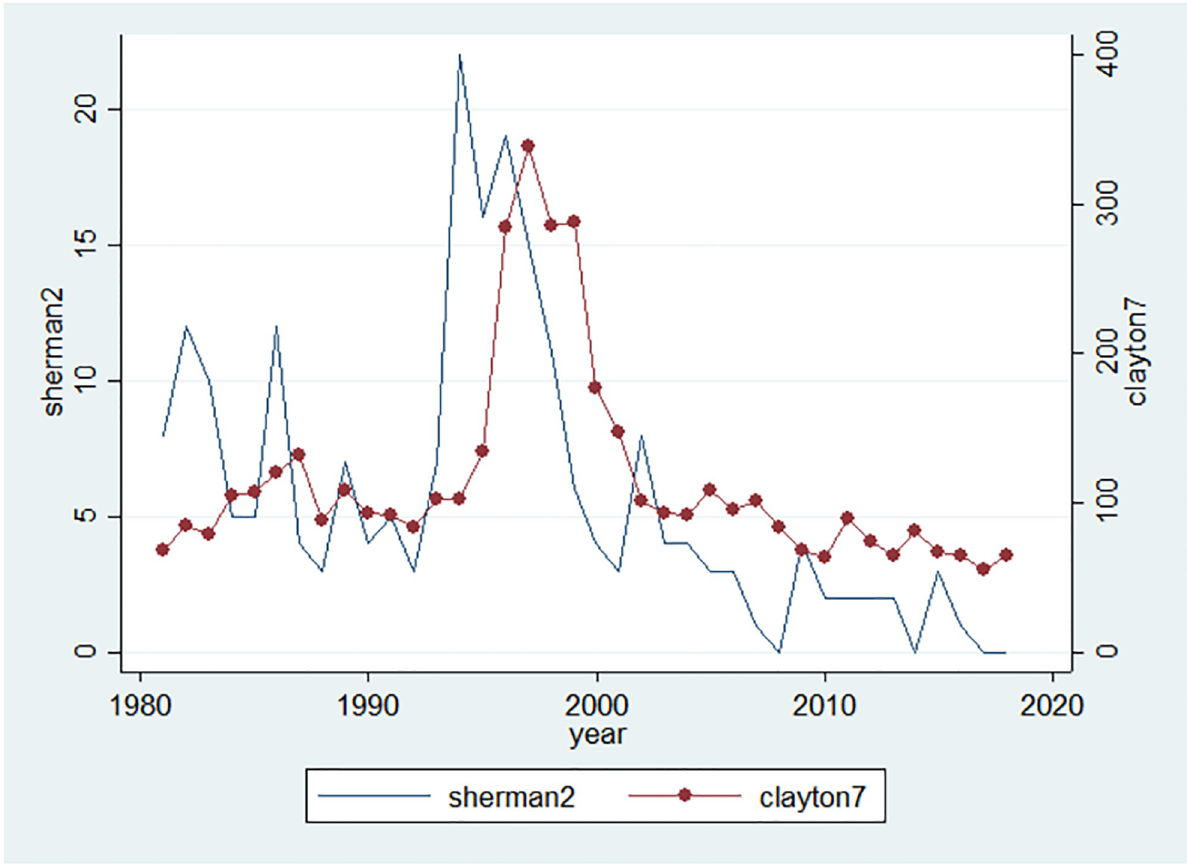
Fig 6. Antitrust enforcement